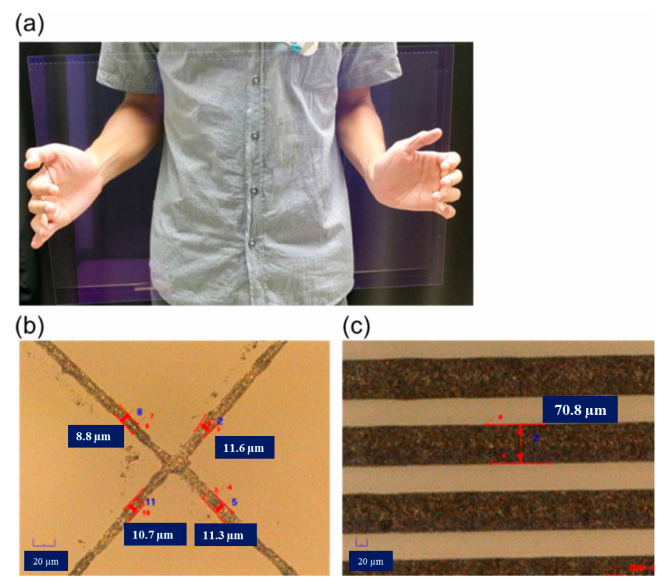
Figure 9. ( a ) The picture of 23 in. metal-mesh printed sample. ( b ) Picture of inner metal mesh of printing sample. ( c ) Picture of outer circuit of printing sample.